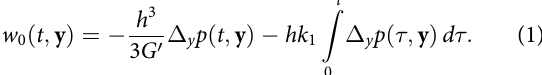
Fr ontiers in Bioengineering and Biotechnology |